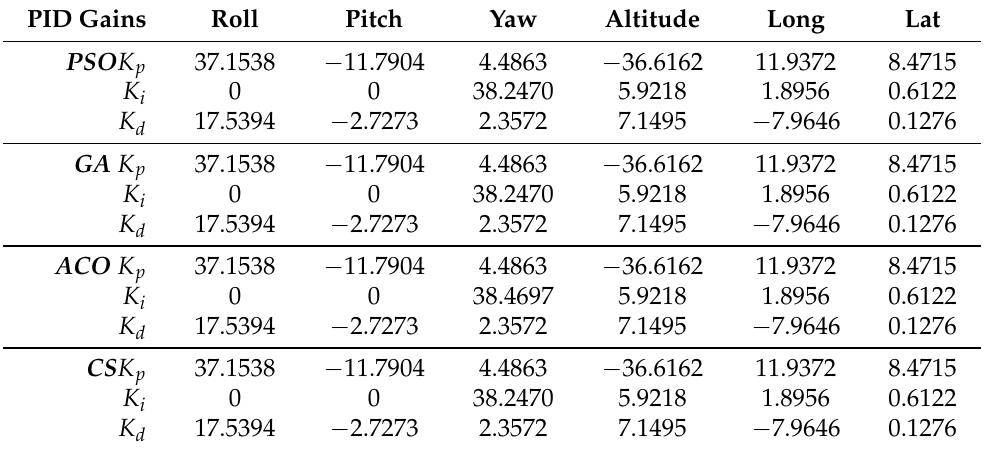
Table 9. The four PID controllers’ gains found using optimisation for the 10 m/s forward flight con- ditions.